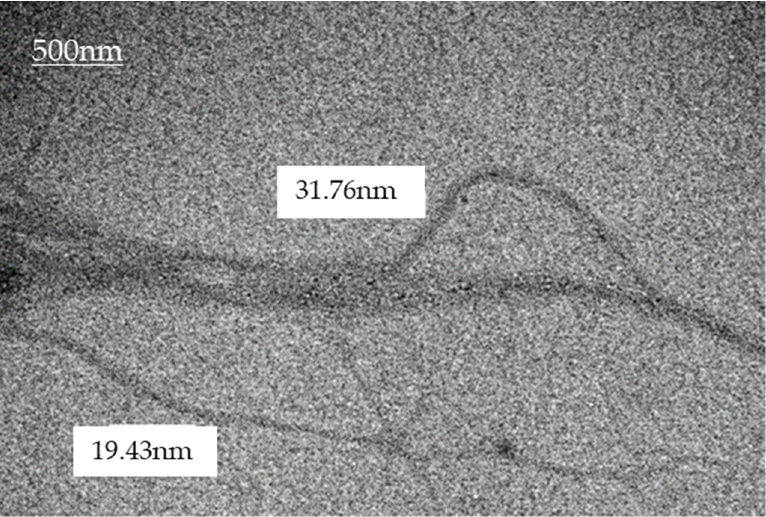
Figure 1. Characterization of nanofibers through Transmission Electron Microscopy